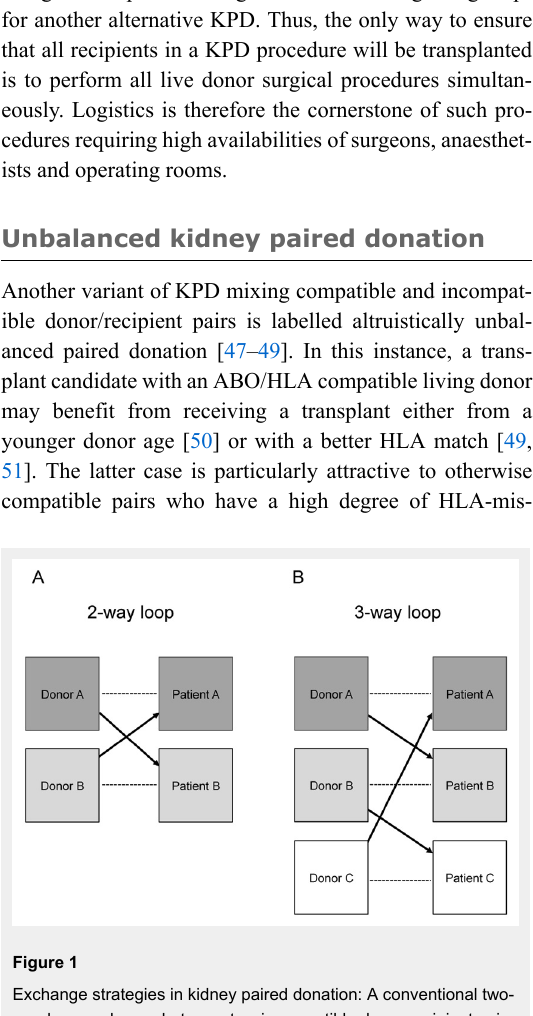
Exchange strategies in kidney paired donation: A conventional two- way loop exchange between two incompatible donor-recipient pairs (A) a three-way loop exchange among three incompatible donor- recipient pairs (B). Multi-way loops can be arranged with three, four, five or more pairs. --- incompatible pair; -> compatible pair.